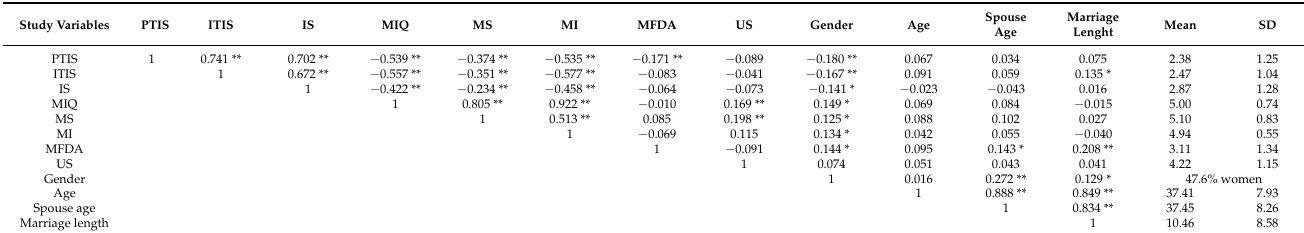
Table 3. Pearson correlations between study variables, means and standard